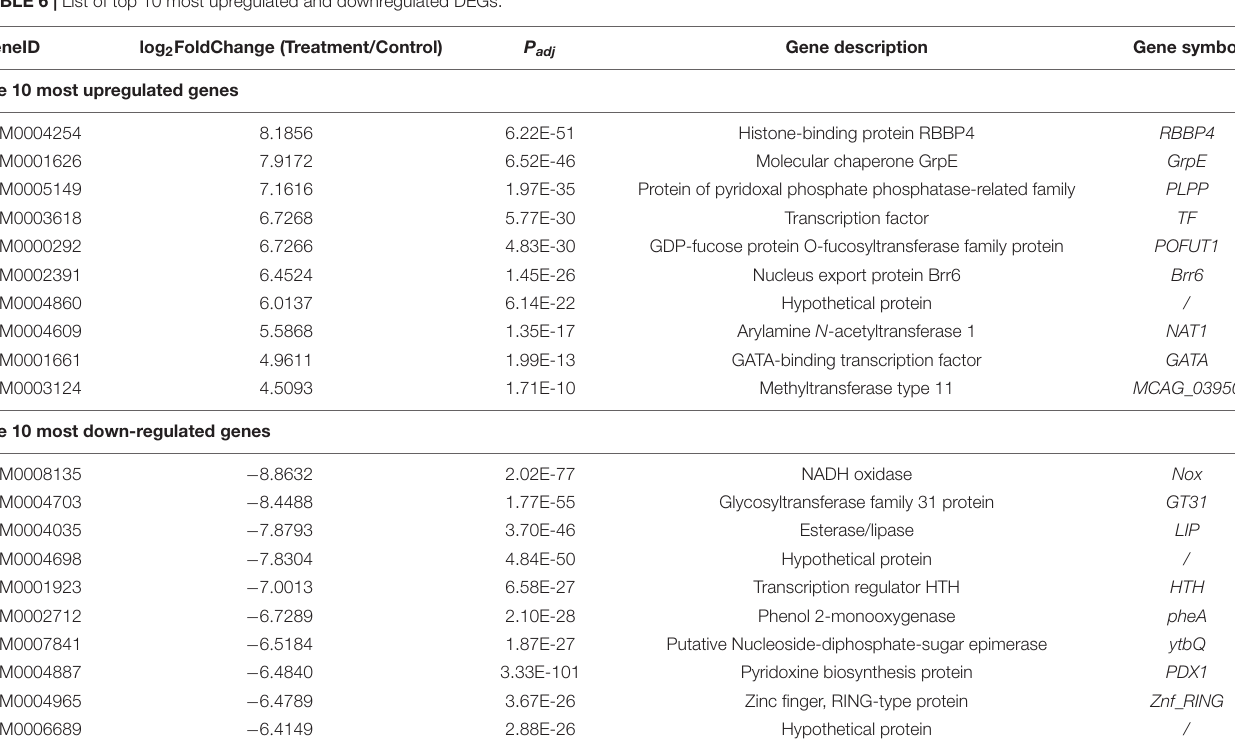
FIGURE 3 | A volcano plot of differentially expressed genes (DEGs). The red spots indicate significant upregulation, whereas blue spots indicate significant downregulation. The black spots signify no significantly changed genes. TABLE 6 | List of top 10 most upregulated and downregulated